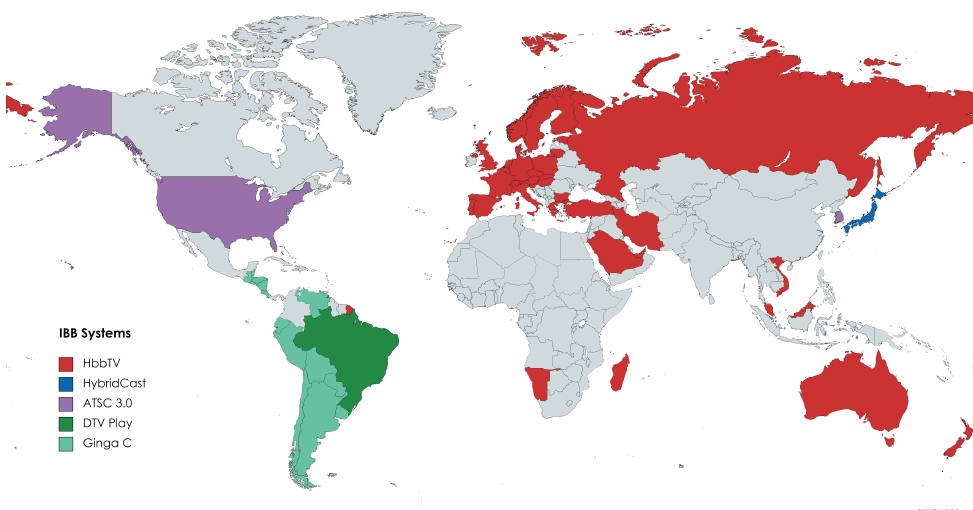
Figure 7. IBB systems deployments in